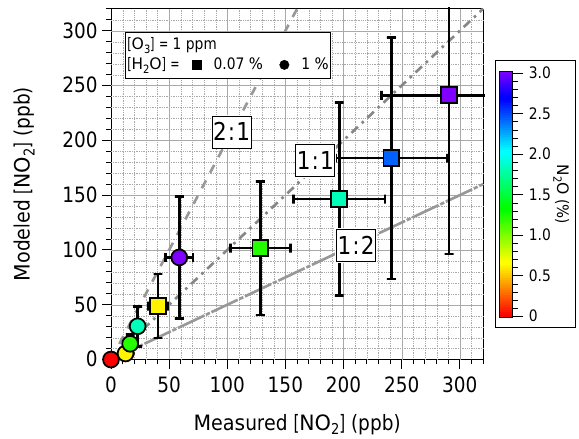
Figure 2. Scatterplot comparing measured and mod- eled [NO 2 ] at 80s residence time in the PAM reactor; I 254 = 4 × 10 15 phcm − 2 s − 1 , [O 3 ] = 1ppm, [H 2 O] = 0.07 and 1%, and [N 2 O] = 0 to 3%. Symbols are colored by [N 2 O], with 1:2, 1:1, and 2:1 lines shown for reference. Error bars represent ± 60% uncertainty in model outputs (Peng et al., 2015) and ± 20% precision in replicate [NO] measurements at fixed [N 2 O].